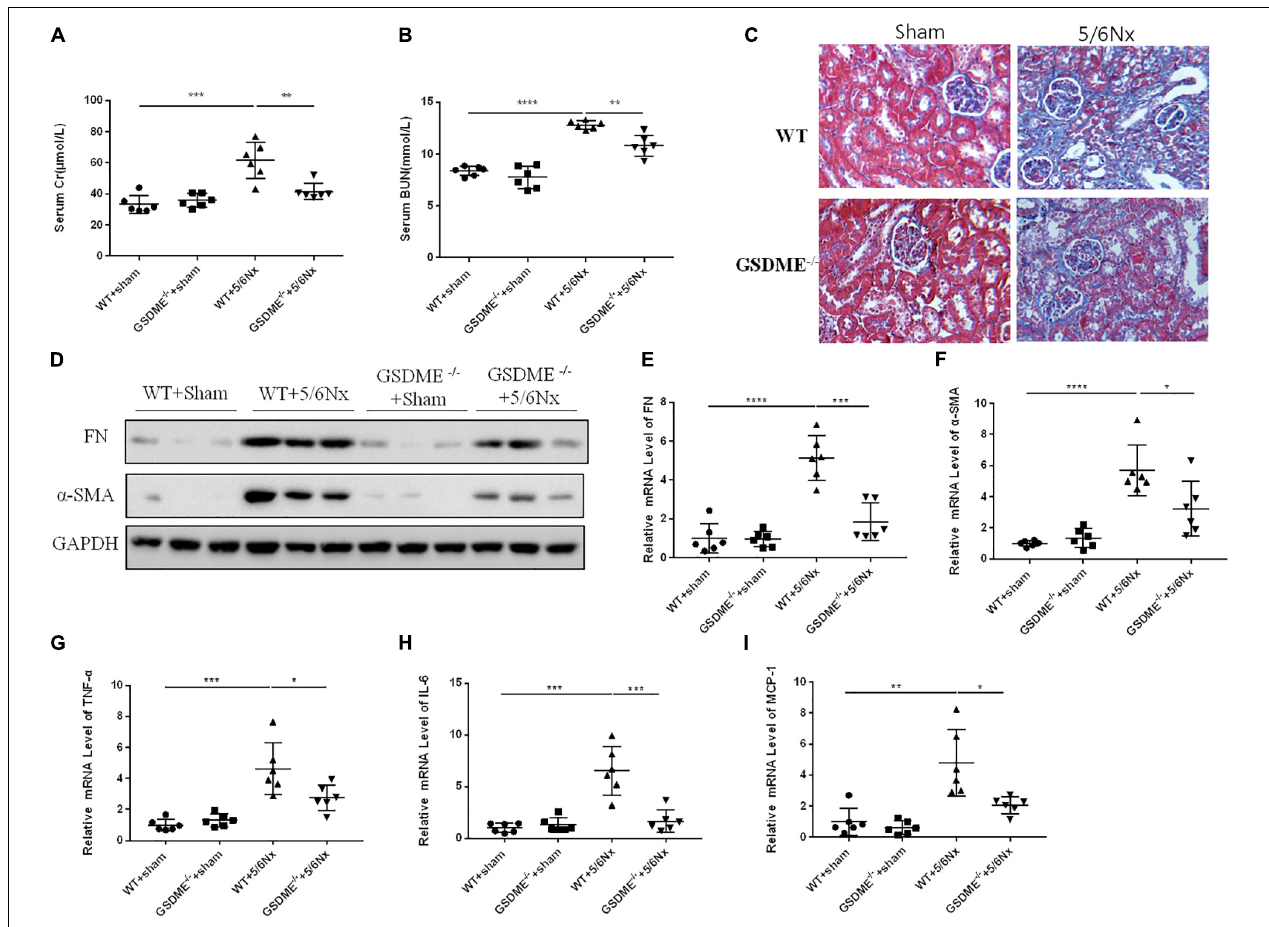
FIGURE 7 | Gasdermin E deletion ameliorates renal fibrosis and inflammatory responses in kidneys challenged with 5/6 nephrectomy (5/6Nx). GSDME KO mice and WT mice were used to determine the role of GSDME in kidneys challenged with 5/6Nx. (A,B) Serum creatinine (CR) and blood urea nitrogen (BUN) levels of GSDME KO mice and controls ( n = 6). (C) Masson staining of kidney sections of GSDME KO mice and WT mice (400 × ). (D) Western blotting analysis of FN and α -SMA in mouse kidneys from different groups ( n = 3). (E,F) qPCR analysis of FN and α -SMA in mouse kidneys from different groups ( n = 6). (G–I) qPCR analysis of TNF- α , IL-6, and MCP-1 in mouse kidneys from different groups ( n = 6). The quantitative results were shown as the means ± SEM. n = 6 in each group. * p < 0.05; ** p < 0.01; *** p < 0.001;**** p <